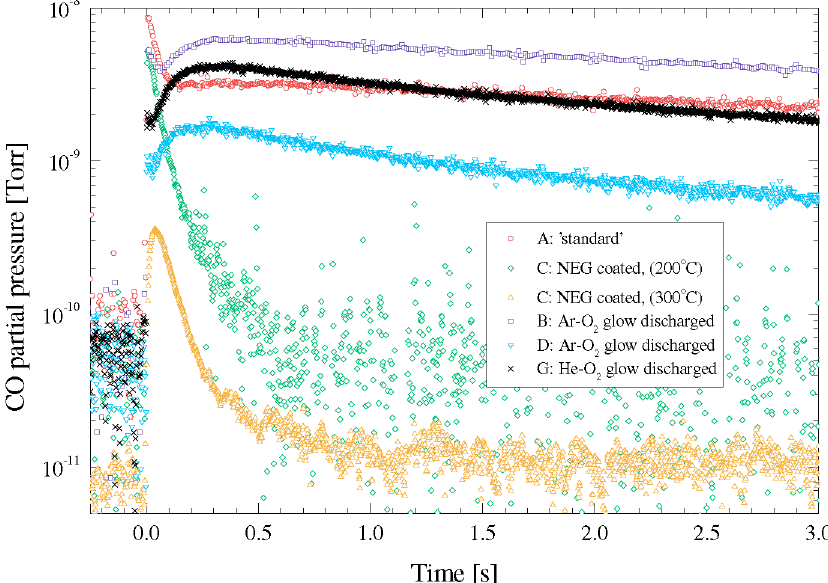
FIG. 6. (Color) CO partial pressure development for five different vacuum chambers measured with pulses of 1 : 5 (cid:2) 10 9 Pb 53 (cid:1) ions at 89.2 (cid:7) grazing